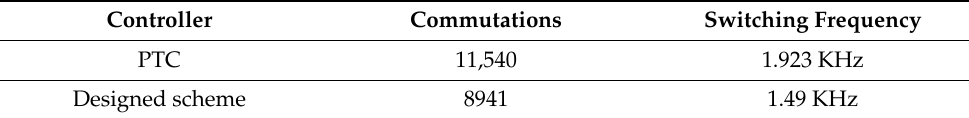
Table 2. Switching frequencies and commutations for the two controllers.